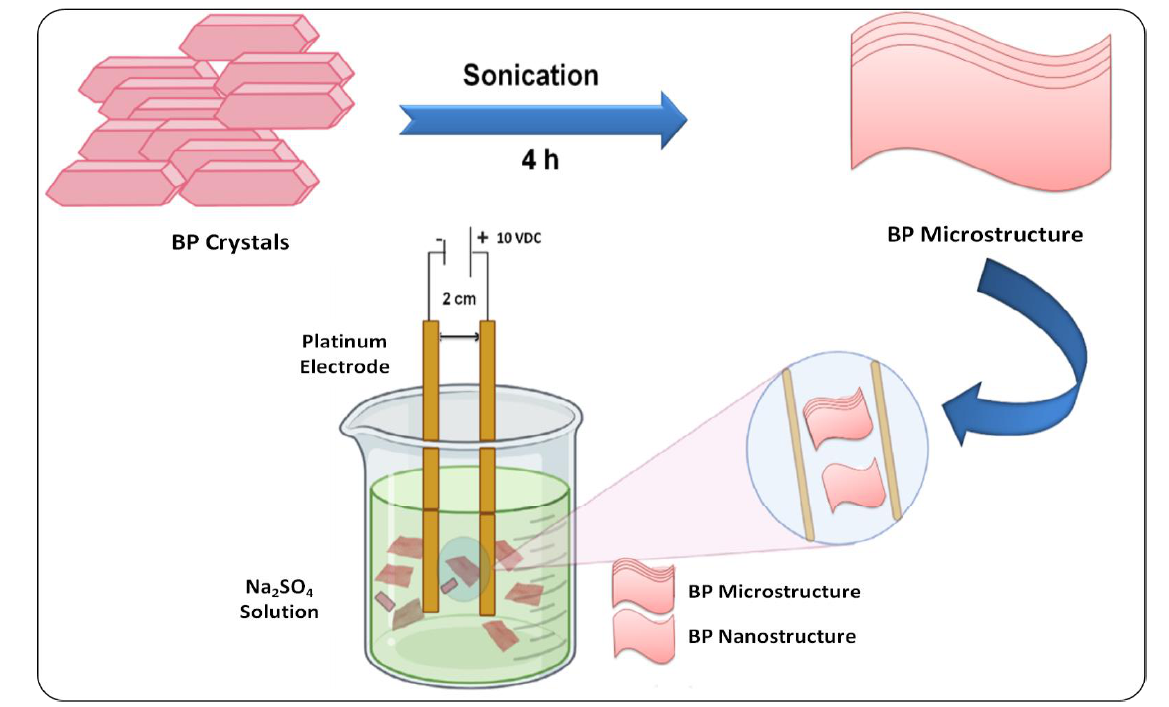
Figure 1. Synthesis of BP nanostructures via electrochemical exfoliation technique.